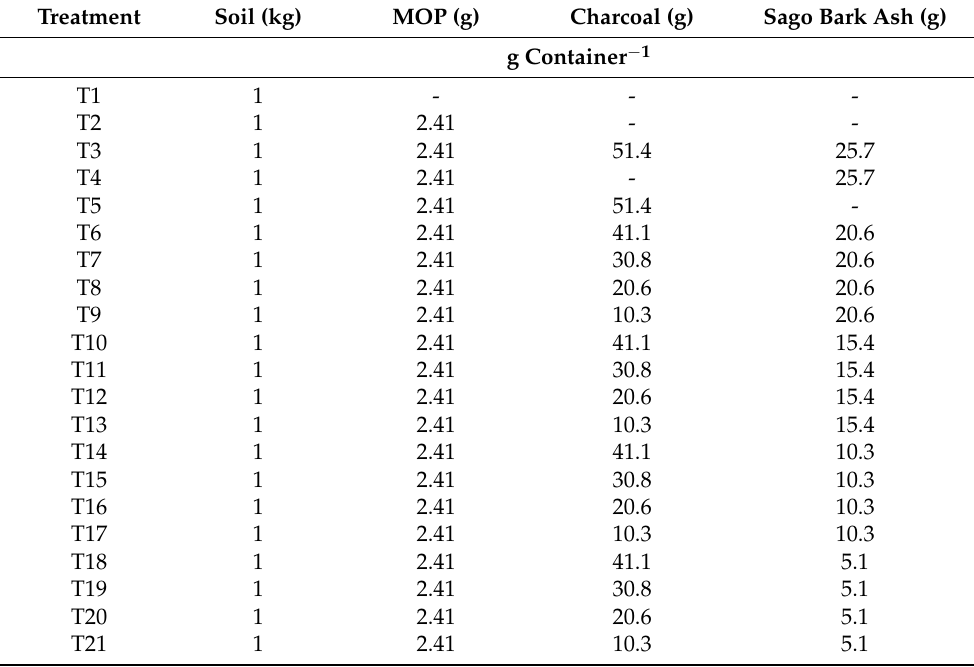
Table 2. Amounts of muriate of potash, charcoal, and sago bark used in the incubation study. Treatment Soil (kg) MOP